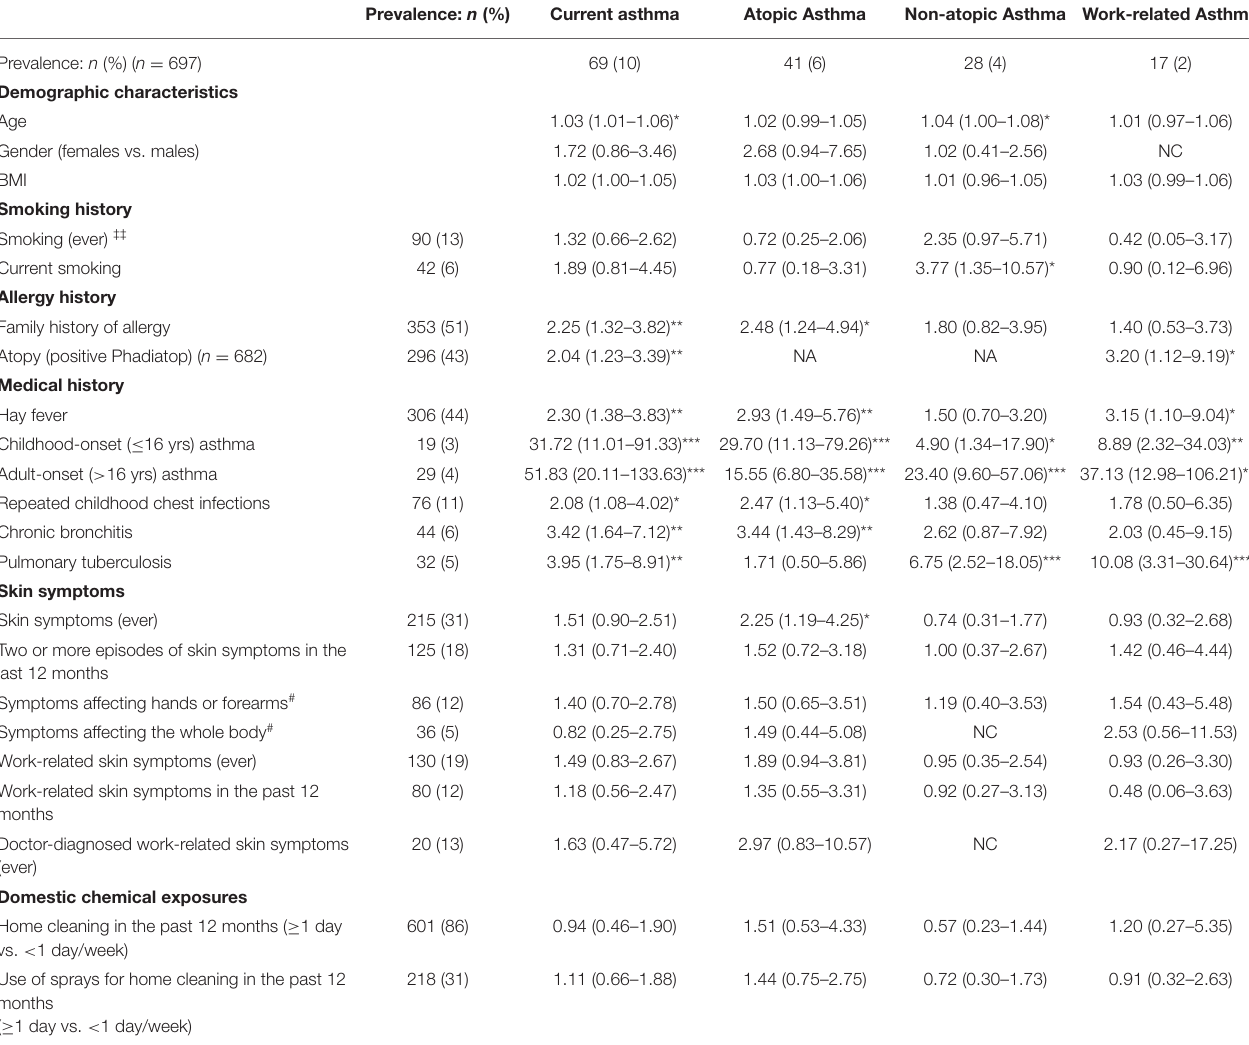
TABLE 7 | Host risk factors associated with asthma phenotypes among health workers working with cleaning